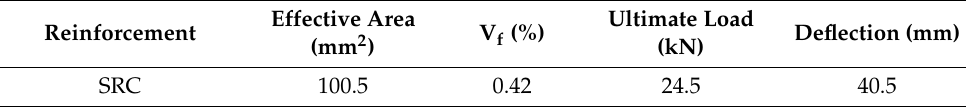
Figure 13. The mods of failure and crack patterns of uni-axial TRC beams. Table 7. Results of control SRC